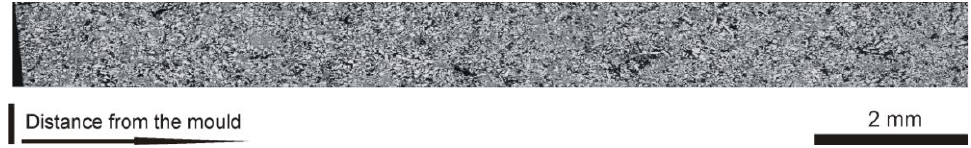
Figure 9. Microstructure evolution with distance from the wall of the mould in bottom part of W – Al- VIM-2 ingot.